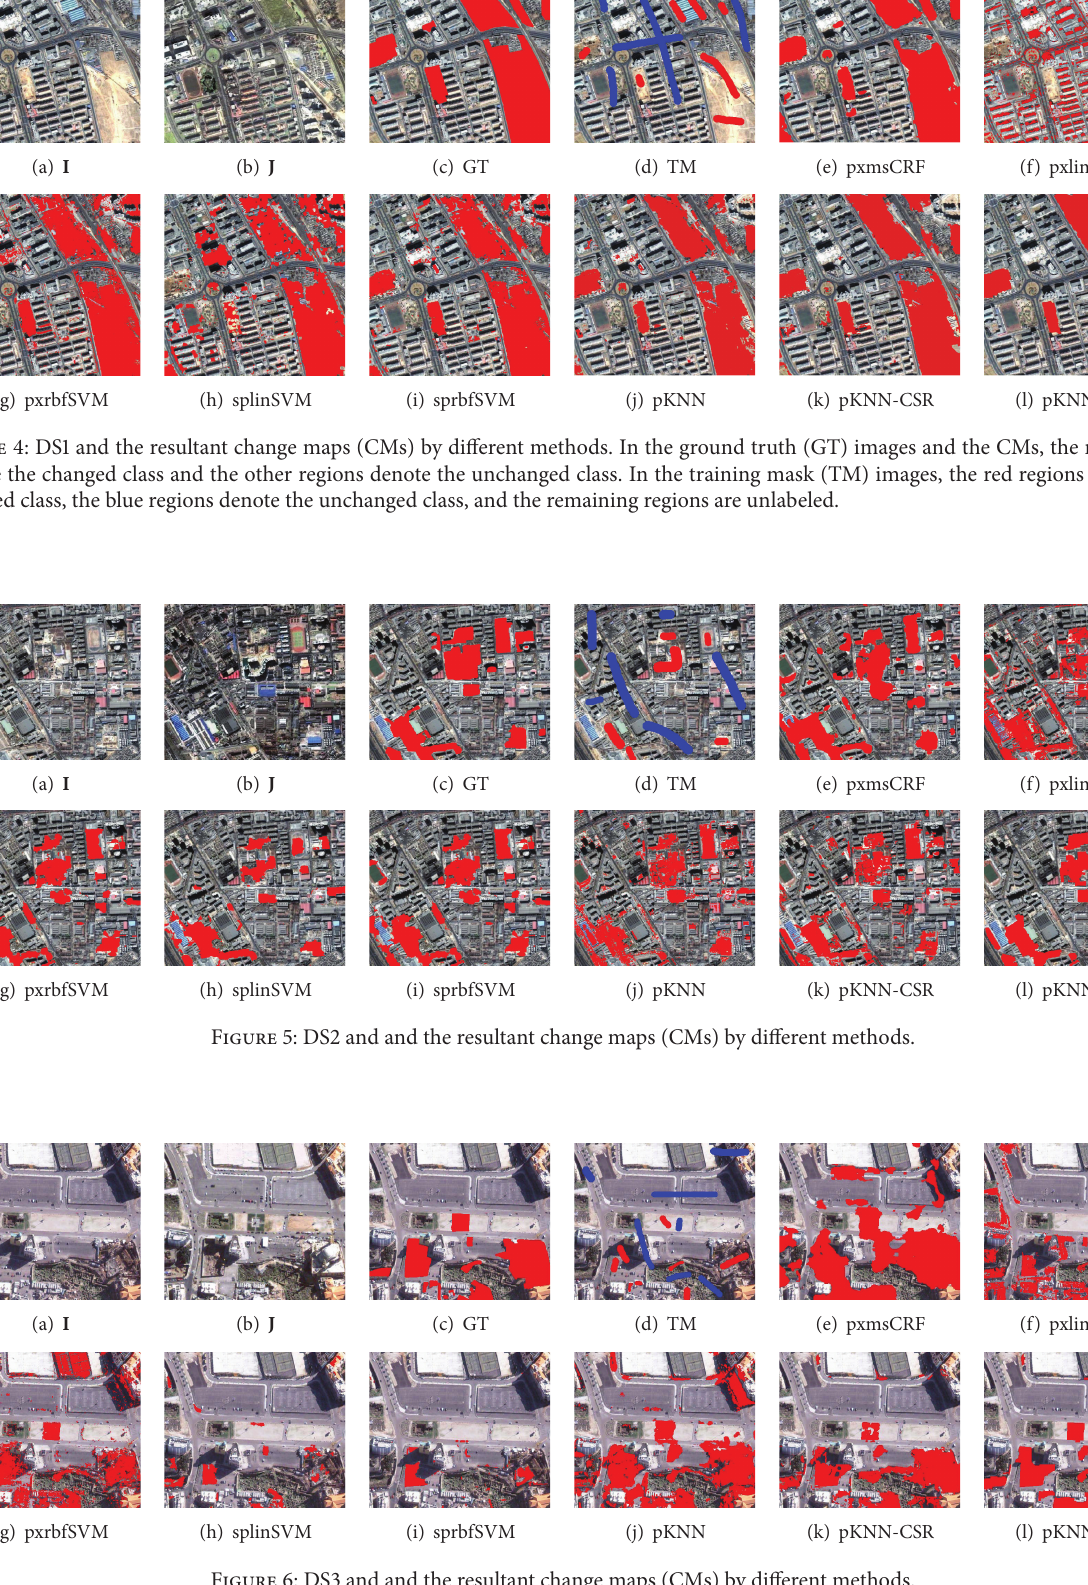
Figure 6: DS3 and and the resultant change maps (CMs) by different